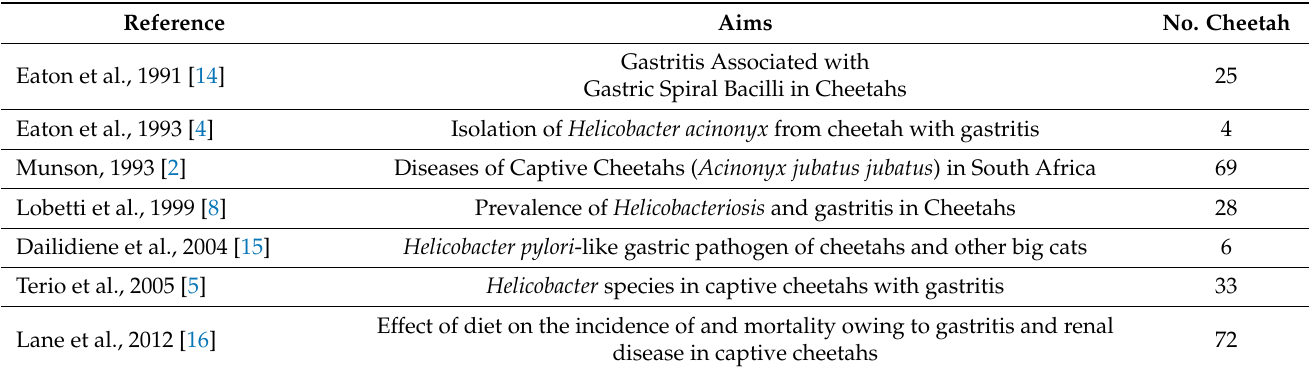
Table 1. Studies about gastroenteric pathologies in cheetahs. No distinction of geographical origin is available, and all animals involved were reported as Acinonyx jubatus